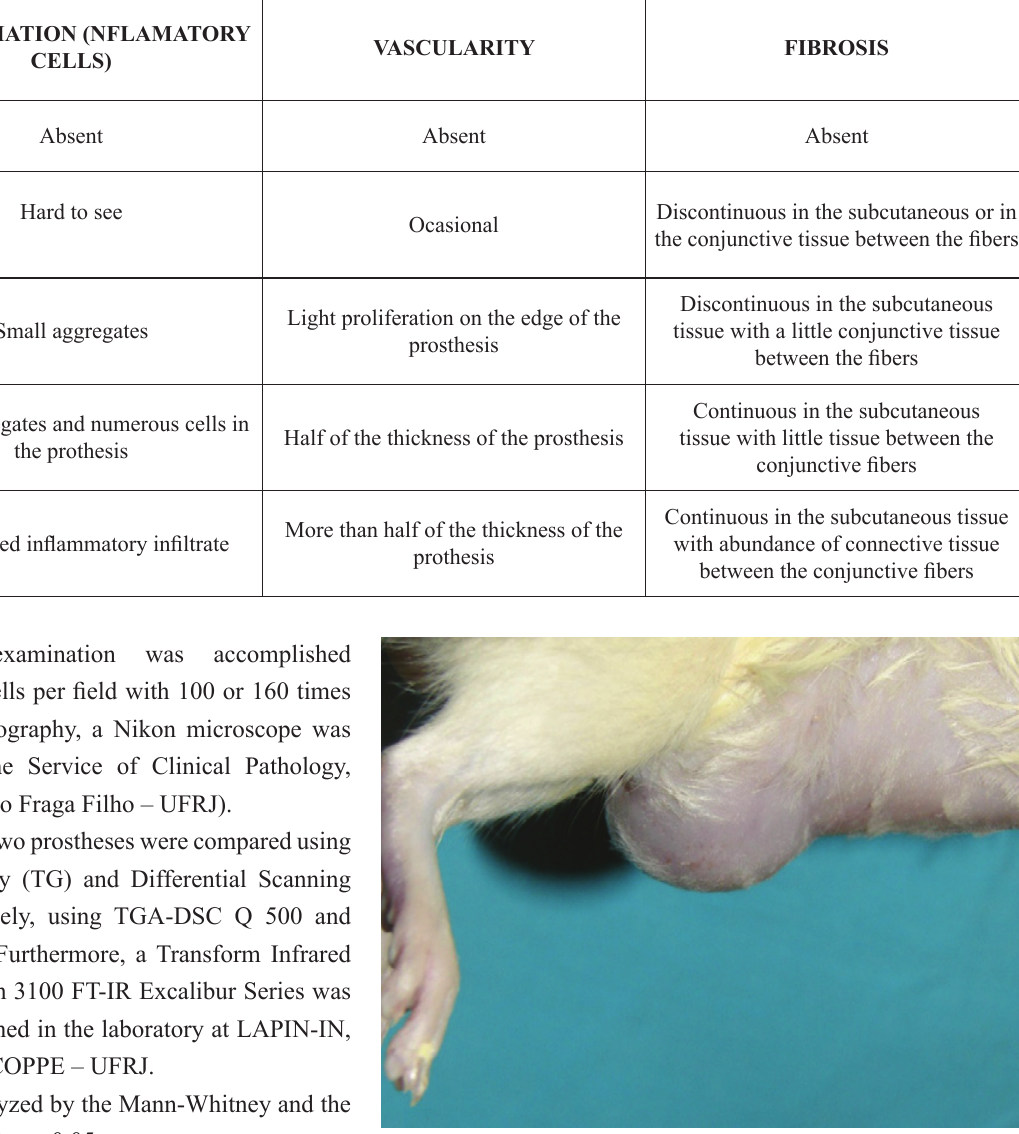
FIGURE 1 - The iatrogenic ventral hernia is easily seen as a protrusion in the abdomen of the